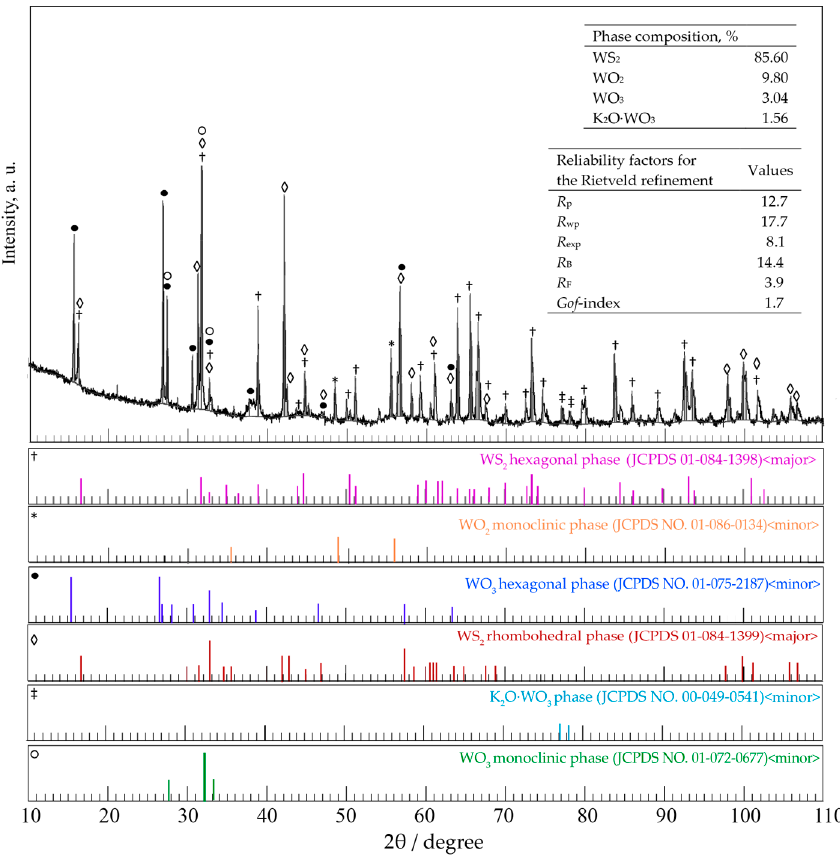
Figure 12. XRD pattern of WS 2 synthesized using WO 3 prepared by USP as precursor. The obtained WS 2 particles were tested for their size and size distribution and the mean particle size was found to be around 950 nm (Figure 13).